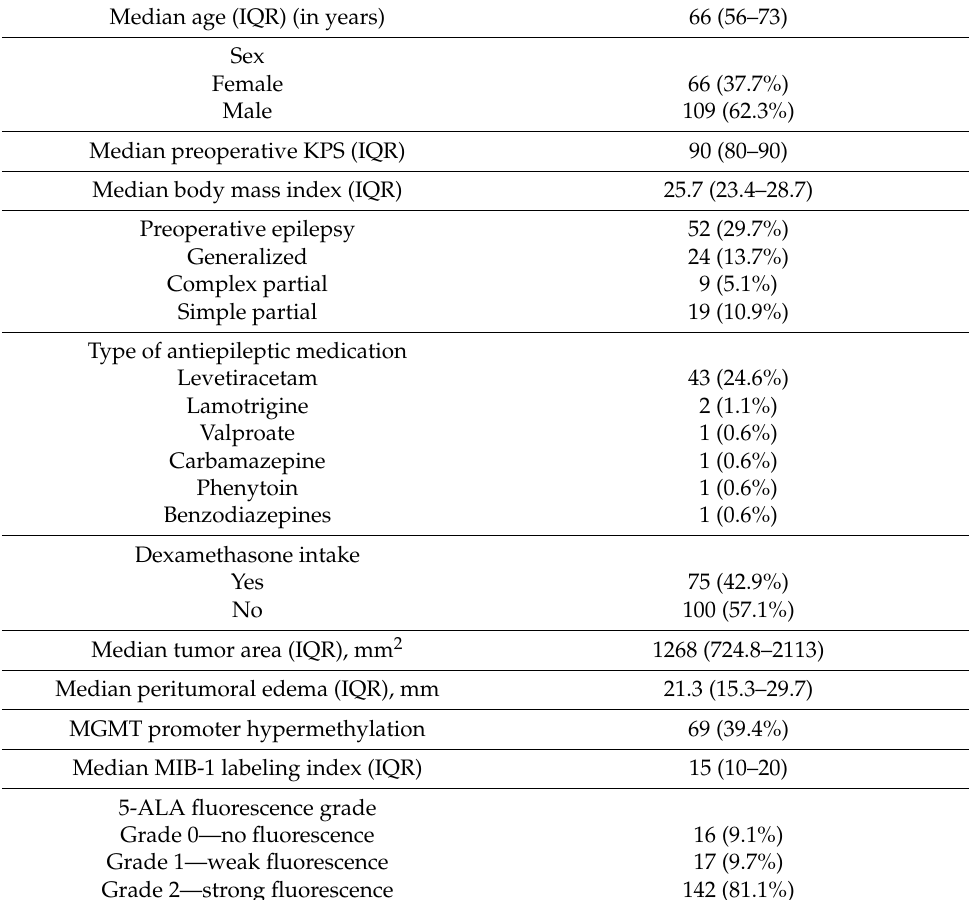
Table 1. Patient characteristics of IDH1 wild-type glioblastoma ( n =